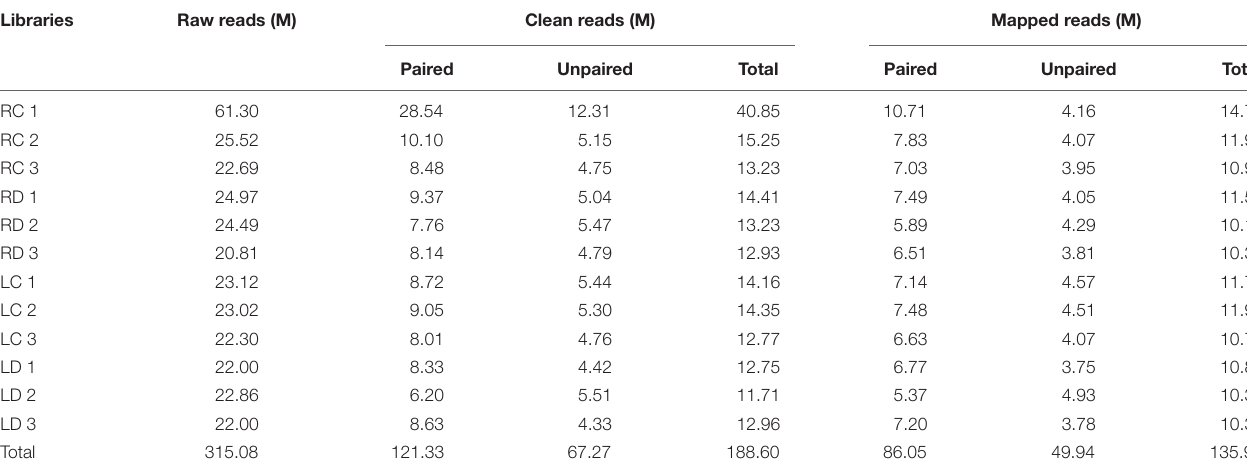
TABLE 2 | Summary of RNA sequencing data in million (M) reads from 12 RNA libraries of control and drought-stressed roots (GF677 rootstock) and leaves (graft, var. Catherina) after 16 days of drought.